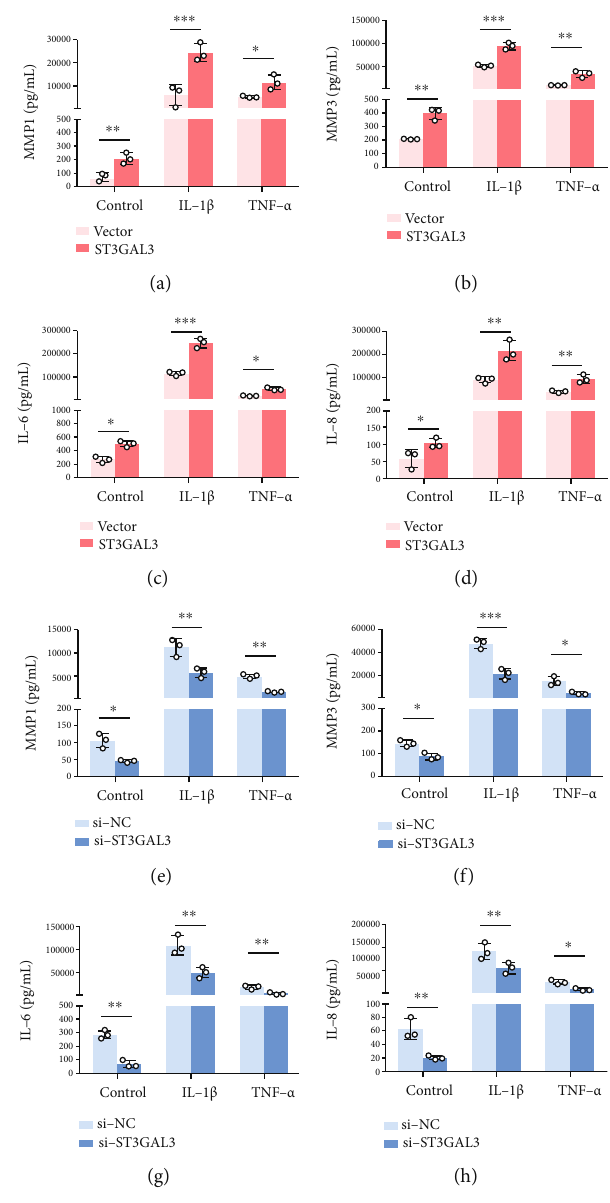
Figure 4: ST3GAL3 promoted the production of MMPs and in fl ammatory factors. (a – d) ELISA results showed that ST3GAL3 overexpression promoted MMP1, MMP3, IL-6, and IL-8 levels. (e – h) ELISA results showed that si-ST3GAL3 inhibited MMP1, MMP3, IL-6, and IL-8 levels. n = 3 . ∗ p < 0 : 05 , ∗∗ p < 0 : 01 , and ∗∗∗ p < 0 : 001 compared with the indicated